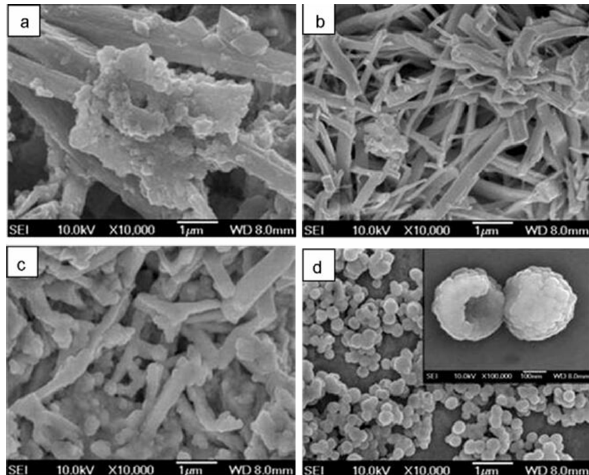
Fig. 2 Y 2 Hf 2 O 7 powders prepared with different concentrations of surfactant: (a) 0%, (b) 0.6%, (c) 1.2%, (d) 1.5%, and calcined at 800 ℃ for 2 h. Reproduced with permission from Ref. [73], © Elsevier B.V.